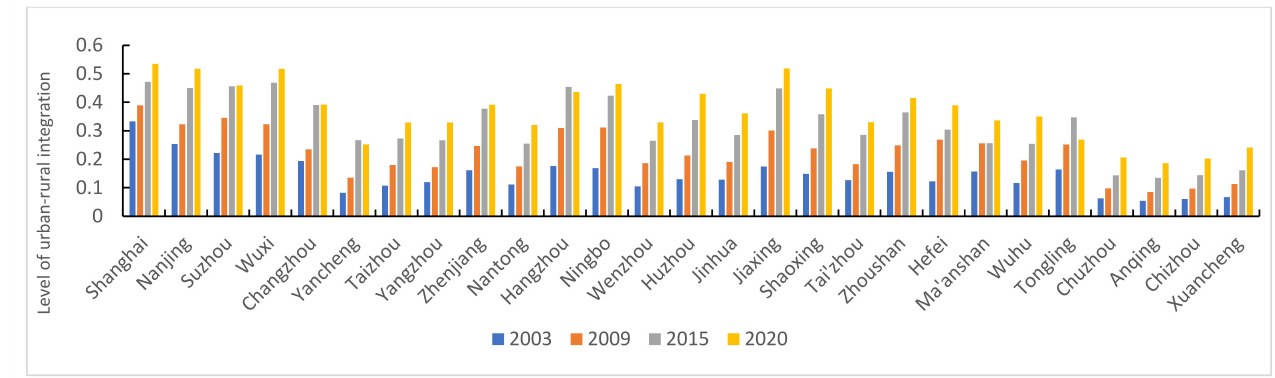
Figure 3. Changes in the level of urban-rural integration development in the central cities of the Yangtze River